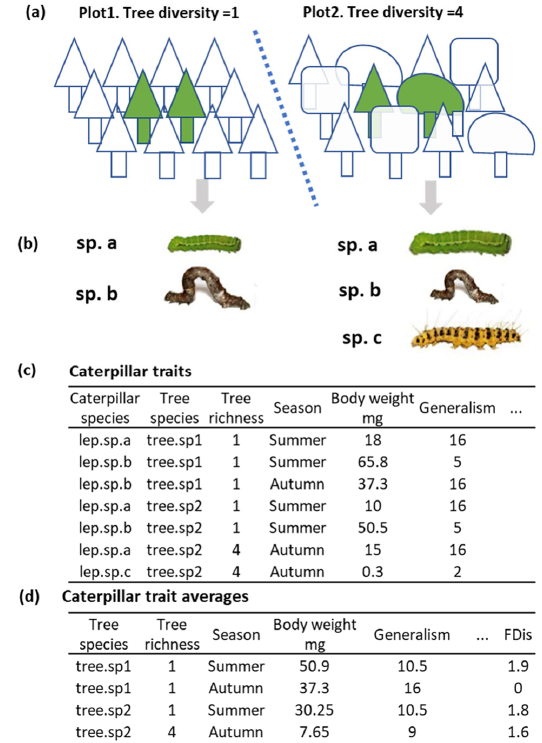
Figure A1. Depiction of the general framework of this study: ( a ) monoculture shown on the left and 4-species mixture on the right; ( b ) caterpillars collected from these tree richness levels during two seasons; ( c ) caterpillar trait averages per caterpillar species per tree species per tree richness per season; ( d ) caterpillar trait averages across caterpillar species per tree species per tree richness per season, as used in subsequent analyses. Averaging of caterpillar values per caterpillar species first per tree individuals not demonstrated for brevity. FDis values were estimated between all traits using caterpillar species averages for each tree species per tree richness level per season. Table A1. Summary of linear model testing for changes in caterpillar trait standard deviations (SD) between tree species. All factors are scaled by subtracting the mean and dividing by standard deviation. All variables except tree replicates, sampling season, and tree richness are log + 1 transformed. Body weight values are also cube root transformed. Standardized parameter estimates (with standard errors, t, and p- values) are shown for explanatory variables. p -values in bold mean p ≤ 0.05, p -values of italic mean p ≤ 0.1.